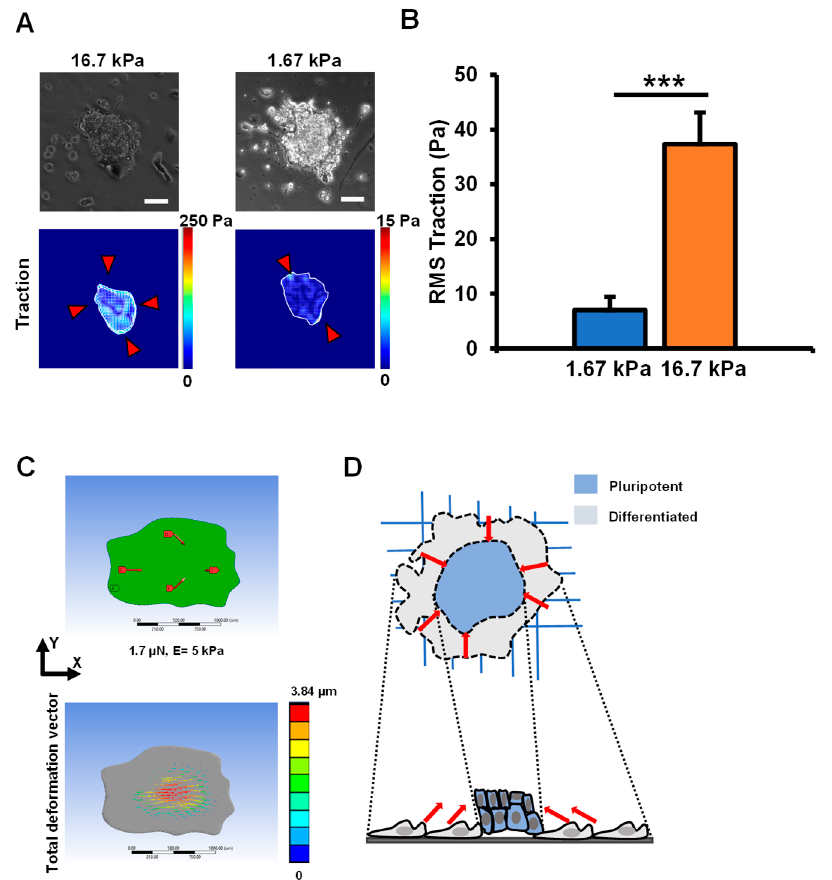
Figure 4. Elevated traction stresses at the EpiSC colony periphery lift the colony center from the surface. ( A ) Representative images of EpiSC colonies cultured on 1.67 kPa and 16.7 kPa PAA substrates and their corresponding traction maps are shown here. Scale bar, 50 µ m. ( B ) Data summary of EpiSC colony r.m.s. tractions on 1.67 kPa and 16.7 kPa substrates is presented here. Data represent mean ± s.e.m. from three independent experiments. n = 16 for 1.67 kPa and n = 10 for 16.7 kPa PAA substrates. Student’s two-tailed t-test was used to conduct statistical analysis for the two groups (***, p = 0.00037). ( C ) ANSYS model was created to represent a pseudo-colony morphology. F = σ r.m.s. * Area was used to calculate force from the traction maps. F = 1.7 µN for the 16.7 kPa PAA gel condition was applied to the model in an in-plane configuration at ~200 µm away from the periphery. ( D ) A proposed model of EpiSC colony differentiation shows that the colony center is elevated due to the force applied on the periphery, which leads to the maintenance of self-renewal of cells in the colony center.